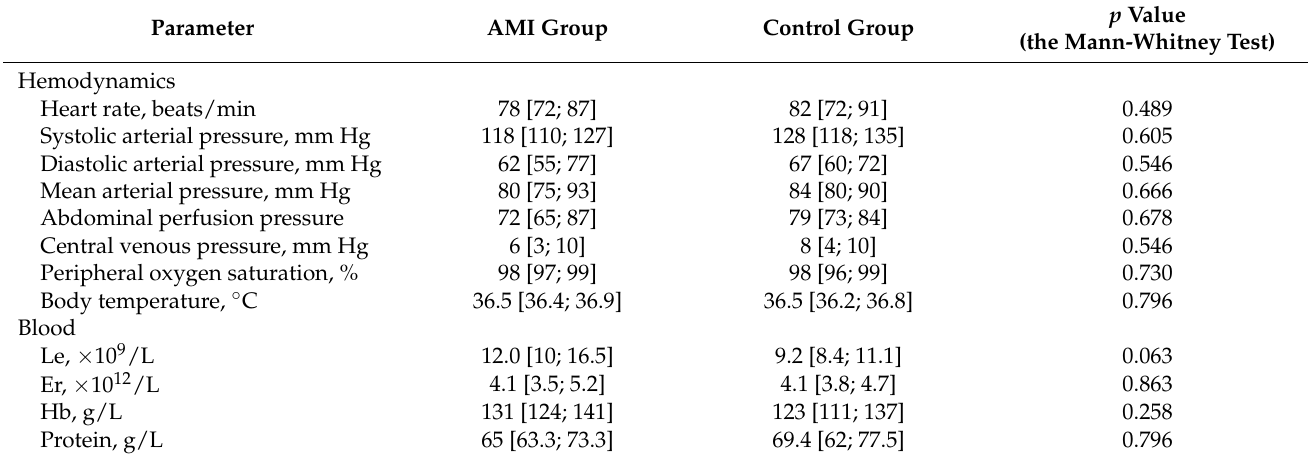
Table 2. Hemodynamic and blood parameters during MM OCT examination, Me [Q1;